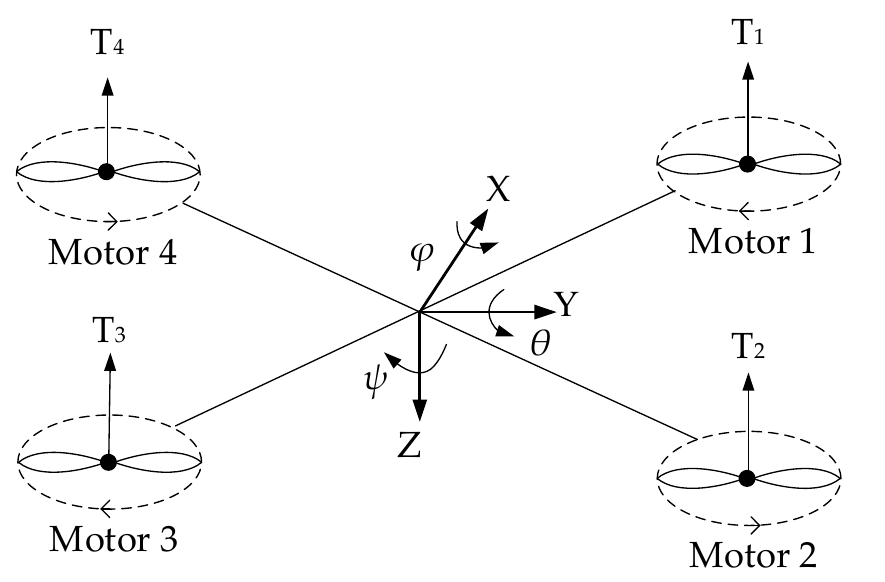
Figure 1. Quadrotor helicopter and the body-fixed frame. The position and attitude of the quadrotor expressed in the inertial frame are defined as P = [ x , y , z ] T and Θ = [ ϕ , θ , ψ ] T , where ϕ , θ , ψ are roll, pitch and yaw angles, respectively. . .. p , p is the speed and acceleration of the quadrotor. The transformation matrix R is used to transform the thrust force from the body-fixed coordinate system to the inertial coordinate system, which is